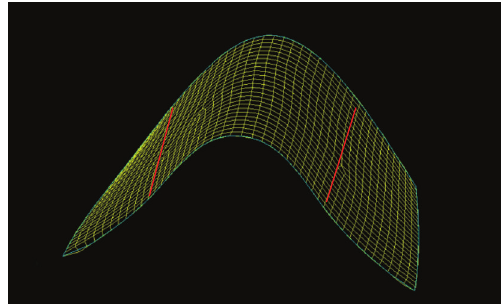
Figure 2: Dorsal surface (specimen D) immediately fore of the dorsal fin describing the “bell shaped” curve. Red lines indicate the approximate position of the lateral